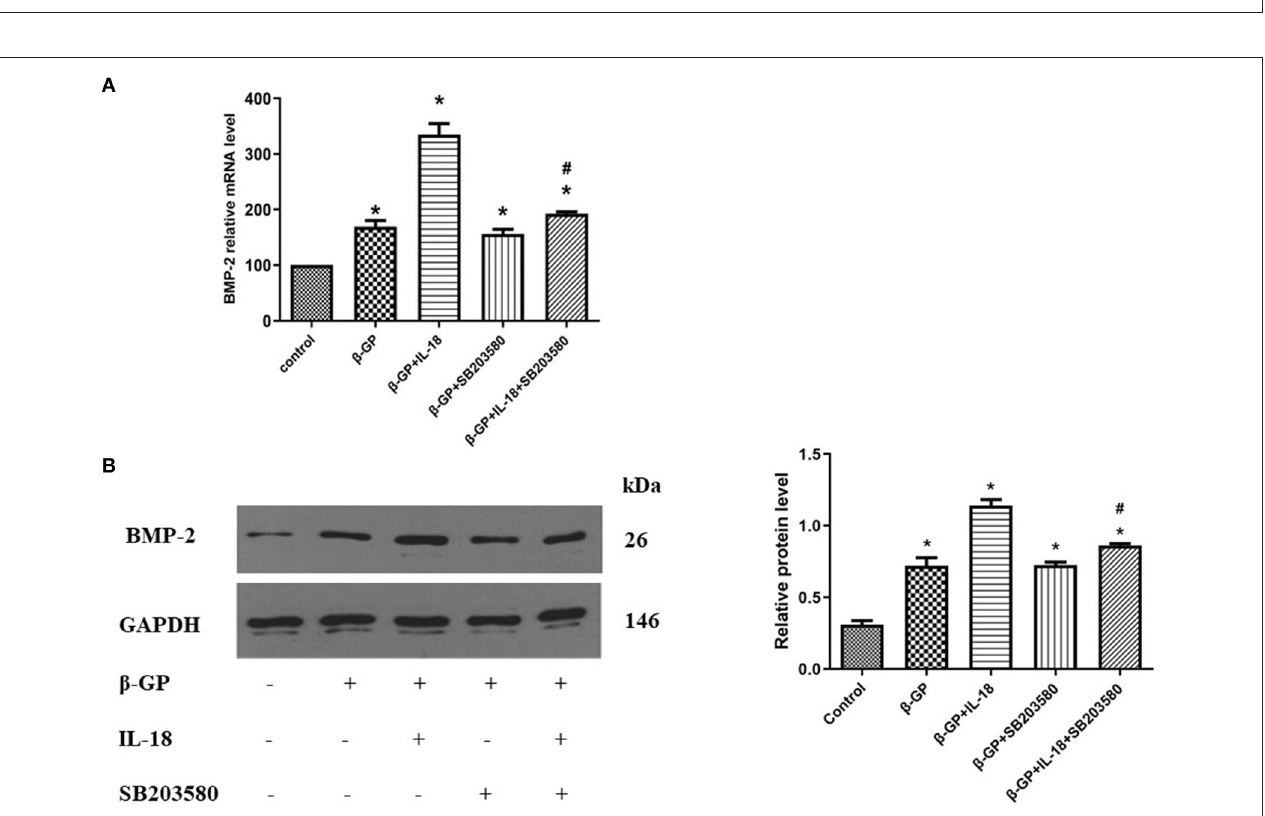
FIGURE 10 | Effect of p38 pathway on IL-18-induced osteogenic phenotypic transformation of rat VSMCs. (A) Effect of p38 pathway on the BMP-2 mRNA expression of rat VSMCs after IL-18 intervention. (B) Effect of p38 signal pathway on the BMP-2 protein expression of rat VSMCs after IL-18 intervention. Rat VSMCs were pre-incubated with p38 inhibitor SB203580 (10 µ mol/L) for 2h, and then treated with β -GP (10 mmol/L) or IL-18 (100ng/ml) + β -GP (10 mmol/L) for 14 days, respectively. The experiment was repeated 3 times independently. * P < 0.01 vs. control group; # P < 0.01 vs. IL-18 + β -GP group. BMP-2, bone morphogenetic protein-2; β -GP, β -glycerol